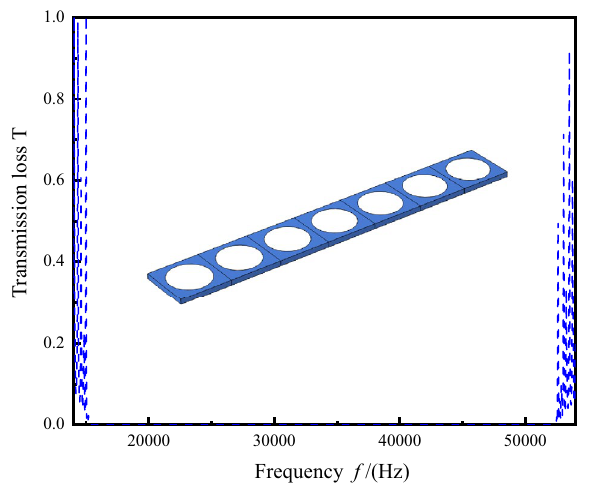
Figure 3. Transmission loss of a 1 × 7 perfect